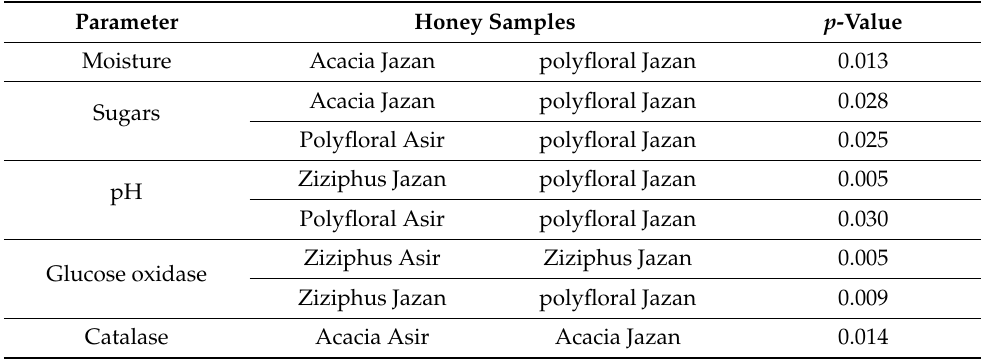
Table 2. The significant effects of the floral and geographical origins on the studied parameters. Parameter Honey